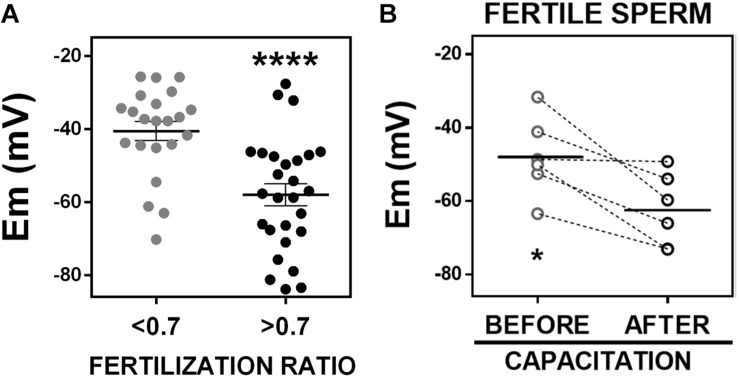
Fertile sperm are hyperpolarized. (A) Sperm membrane potential (Em) values from patients with in vitro fertilization ratios <0.7 (n = 22; –40.61 ± 2.60 mV) or >0.7 (n = 27, –58.03 ± 3.00 mV). ∗∗∗∗P < 0.0001 by unpaired t-test. (B) Membrane potential of fertile frozen sperm samples from patients that conceived a pregnancy, incubated in commercial capacitating media for 1 h (before capacitation, –47.92 ± 4.38 mV) or 18 h (after capacitation, –62.51 ± 4.05 mV). n = 6, ∗P = 0.0146 by paired t-test.